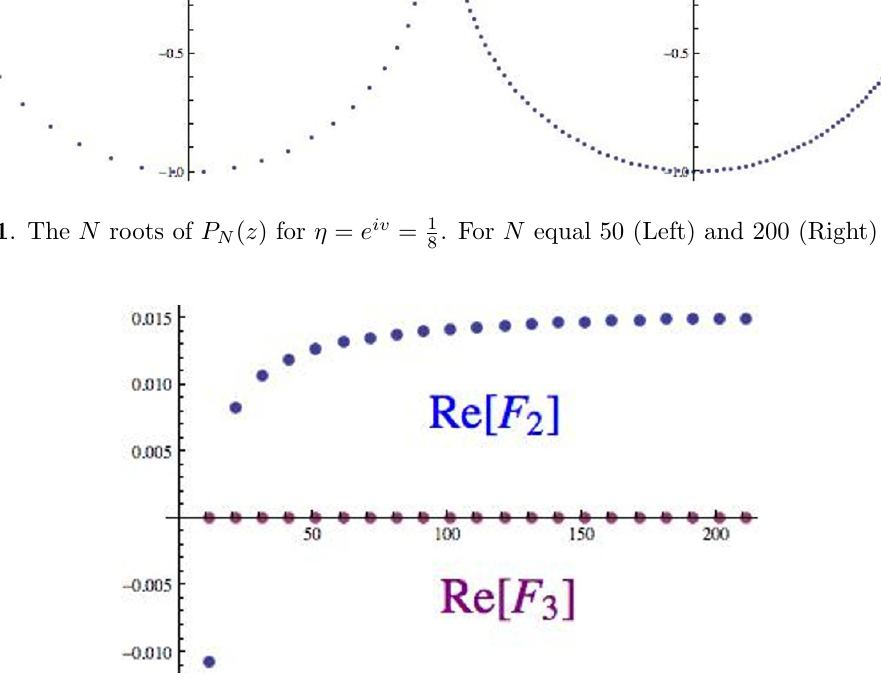
Figure 2 . The real part of the components, F 2 ( N ) and F 3 ( N ) of the free energy (4.7) for N ranging between 11 and 211 at step